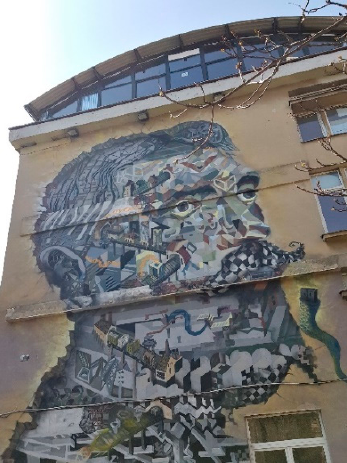
Figure 37. Ion Mincu, UAIM, Bucharest by Obie Platon, Sandu Milea Lucian, and Alex Brat, 2016 (photo taken in 2022).